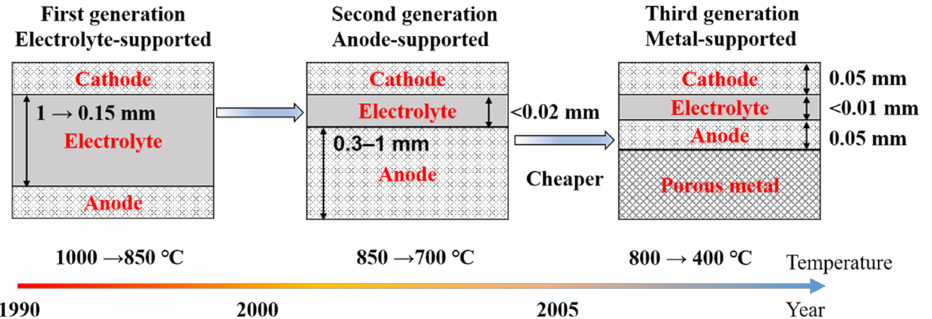
Figure 2. Schematic diagram of the development of SOFCs [9,22]. Note the thinner electrolyte allows a lower operating temperature, and the low operating temperature allows the use of metal supports.